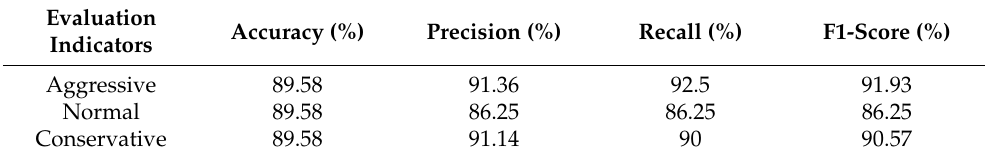
Table 19. Various evaluation indicators of the BPNN driving propensity identification